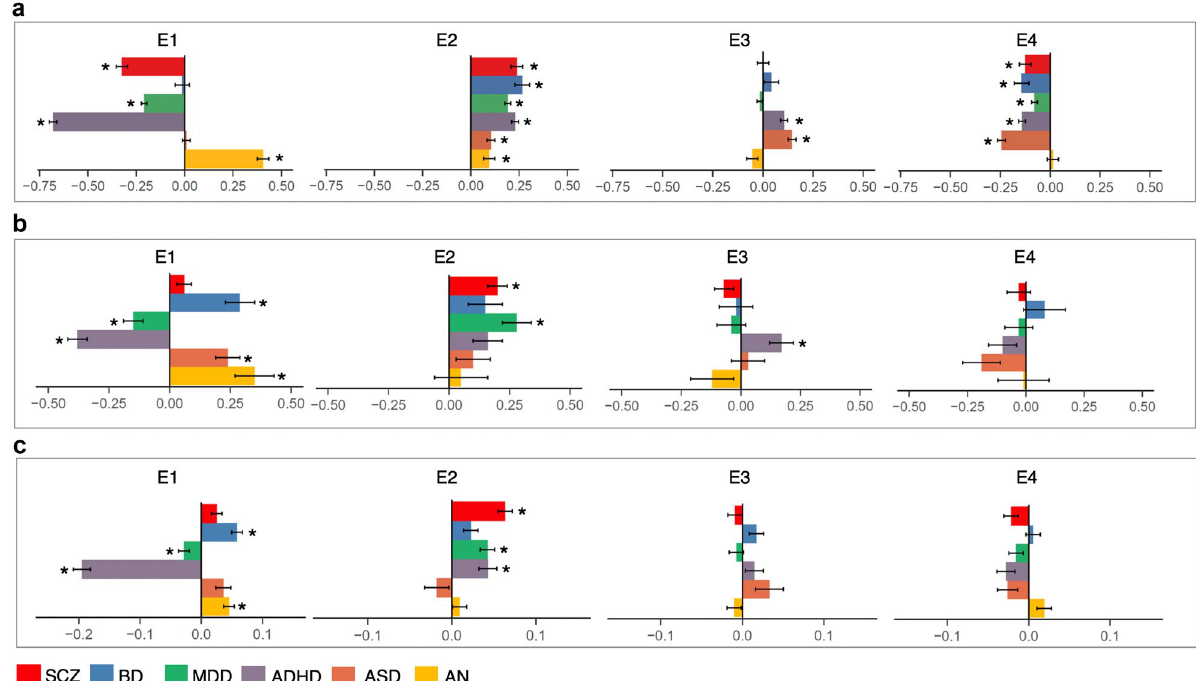
Figure 3. Phenotypic and genetic associations of E-factors with psychiatric disorders. ( a ) Phenotypic associations of the E-factors with the six psychiatric disorders tested using logistic regression. Standardised effect sizes (beta coefficient) along with standard errors are shown; ( b ) Genetic correlations (r g ) of the E-factors with the six psychiatric disorders estimated using bivariate LD score regression; ( c ) Associations of polygenic scores for the six psychiatric disorders with the E-factors analyzed only in the controls (N = 12,487). Beta coefficients and standard errors are shown. Star symbols indicate statistical significance after multiple